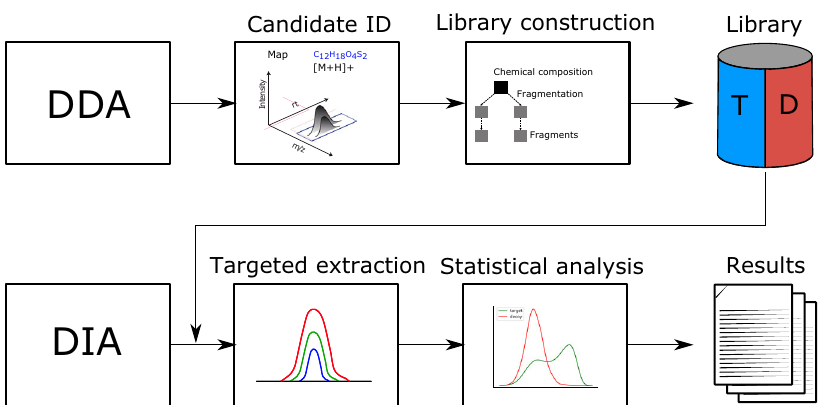
Fig. 1 DIAMetAlyzer - a pipeline for assay library generation and targeted analysis with statistical validation. DDA data is used for candidate identi fi cation containing feature detection, adduct grouping and accurate mass search. Library construction uses fragment annotation via compositional fragmentation trees (SIRIUS) and decoy generation using a fragmentation tree re-rooting method (Passatutto) to create a target-decoy assay library. This library is used in a second step to analyse metabolomics DIA data by performing targeted extraction (OpenSWATH), scoring and statistical validation